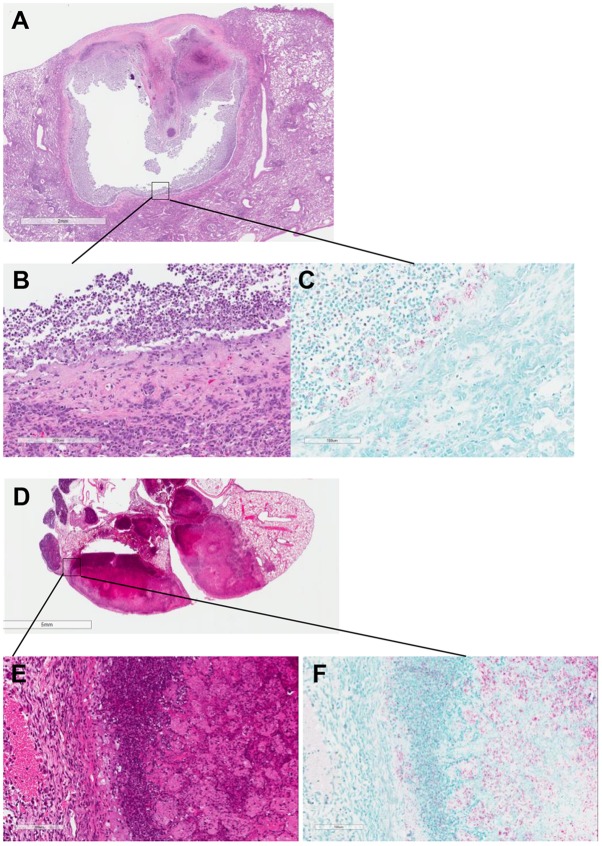
Histopathology of caseous lesions in untreated C3HeB/FeJ mice at different incubation times. (A) Lung cavity formed in a C3HeB/FeJ mouse after 26 weeks of incubation. (B,C) Cavity wall with H&E (B) and acid-fast bacilli (AFB; C) staining. (D) Sick mouse after 8 weeks of incubation. (E,F) Granuloma wall with monocyte infiltration and foamy macrophages with H&E (E) and AFB (F) staining. Scale bars: 2 mm (A); 200 μm (B); 100 μm (C,E,F); 5 mm (D).